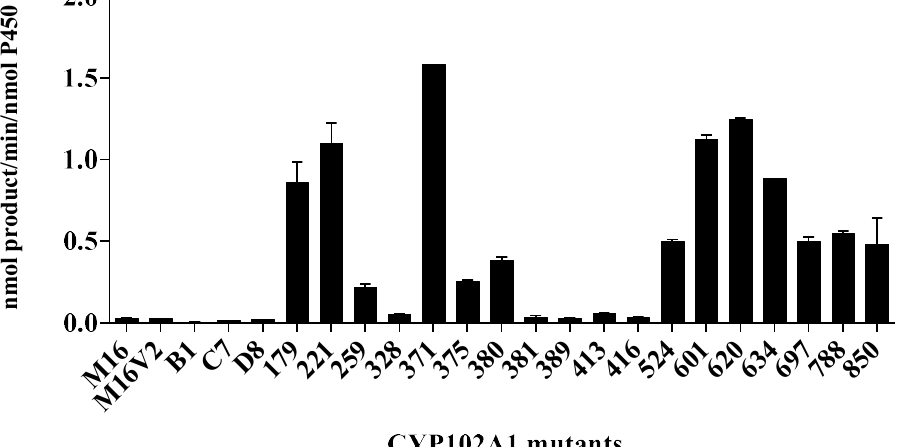
Figure 2. Phlorizin hydroxylation activity of CYP102A1 mutants. The reaction mixture contained phlorizin (200 μM) as a substrate in potassium phosphate buffer (100 mM, pH 7.4) and 0.40 μM of each CYP102A1 mutant. To initiate the reaction, NADPH-generating systems were added and the reaction was performed for 30 min at 37 °C.